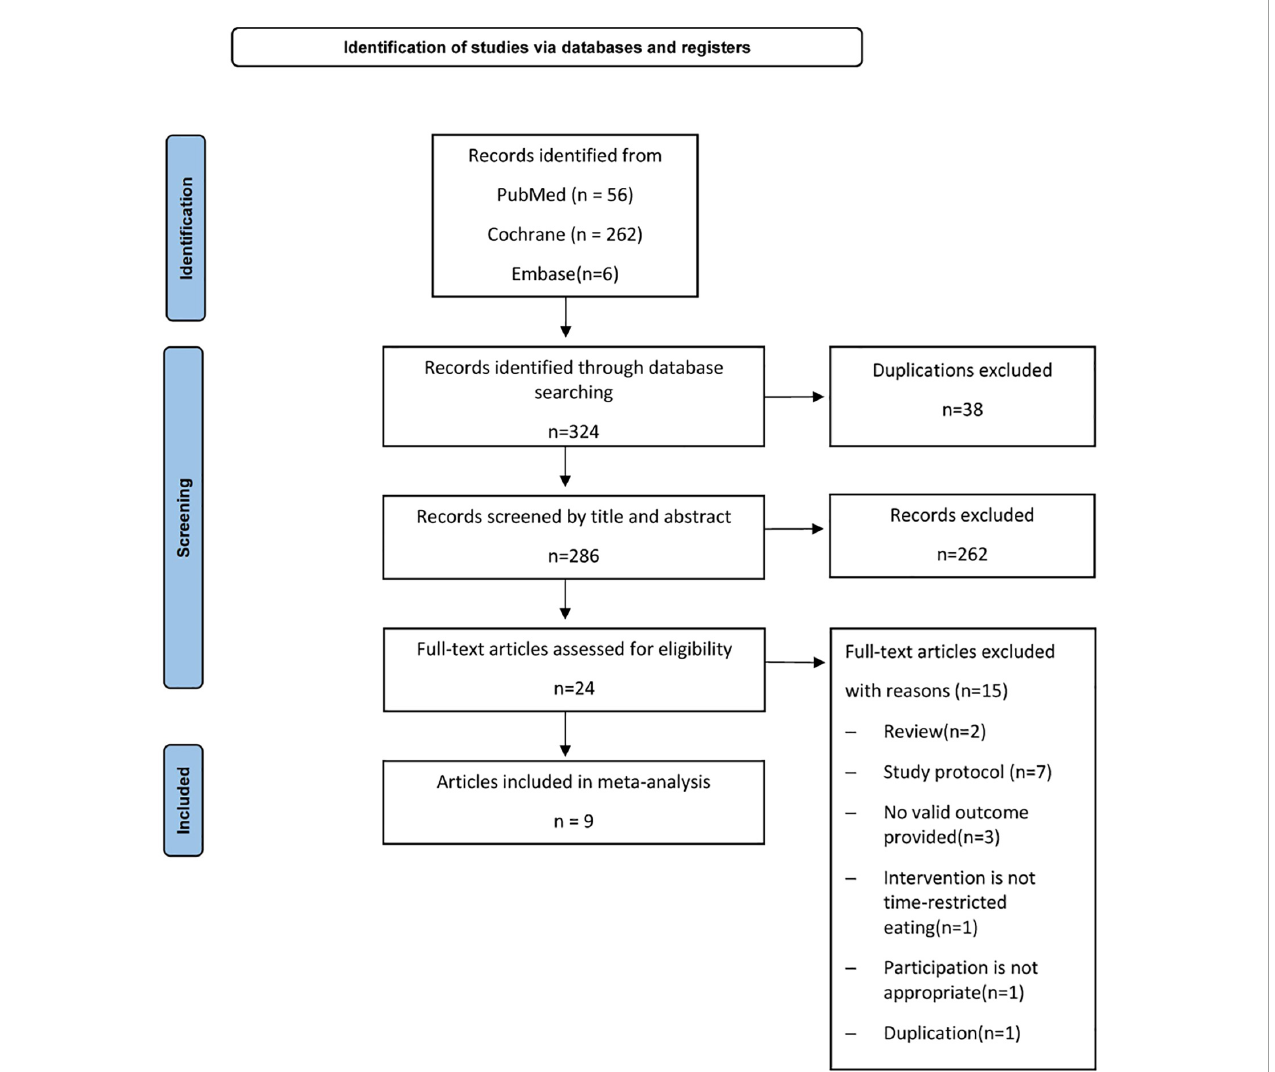
FIGURE1 PRISMA (Preferred Reporting Items for Systematic Reviews and Meta-Analyses) flow